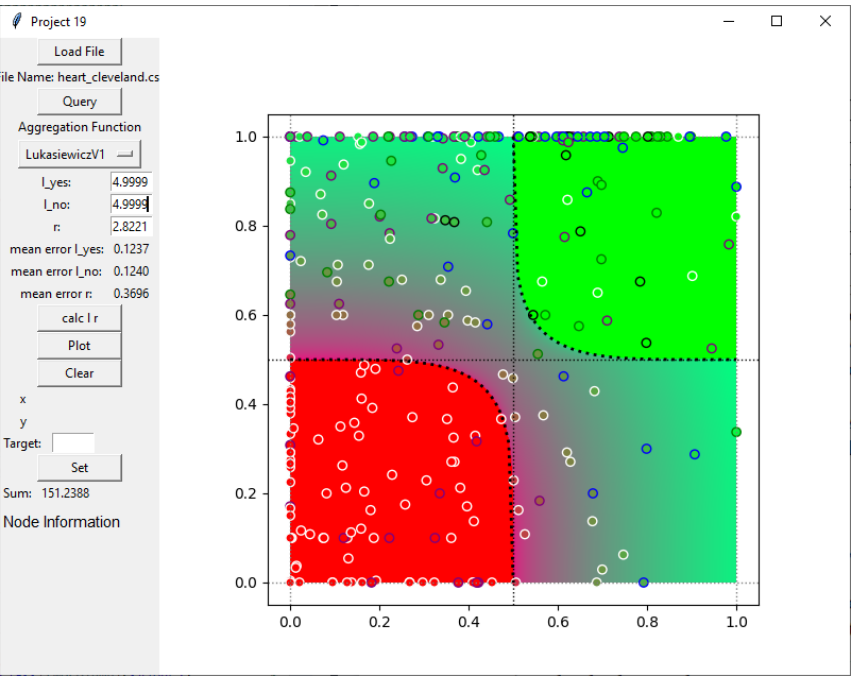
Figure 17. Result of calculating λ and r after assigning to each patient the target value of 1 for yes if the patient has heart disease and 0 for no if the patient has no heart disease. The classification space is presented as red for definitive no , green for definitive yes and a gradient from pink (tendency more to no ) to turquoise (tendency more to yes ) for maybe